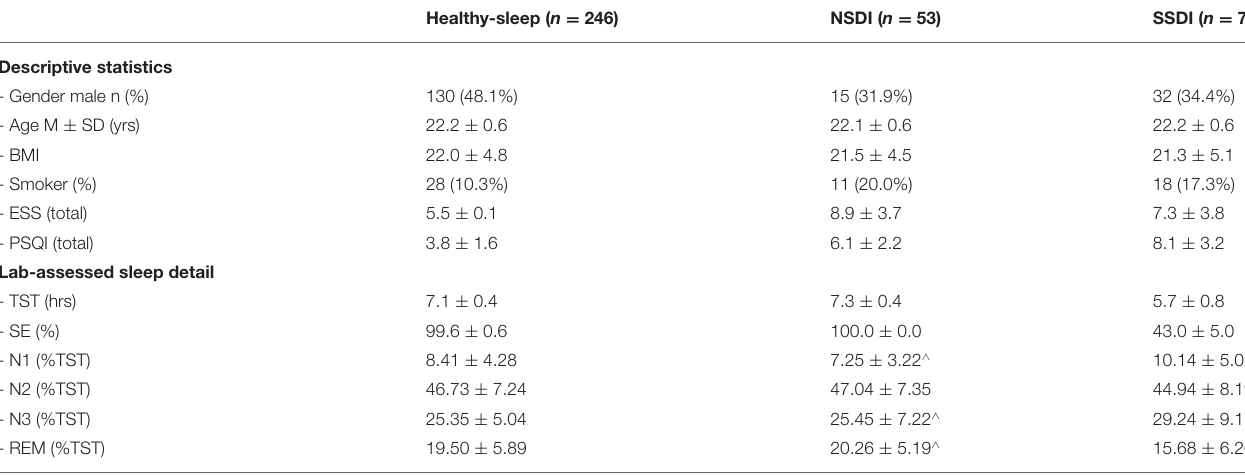
TABLE 1 | Descriptive statistics and lab-assessed sleep detail (PSG staged sleep; Stage as % of total sleep time) for the healthy sleepers, those with NSDI, and SSDI. Healthy-sleep ( n =